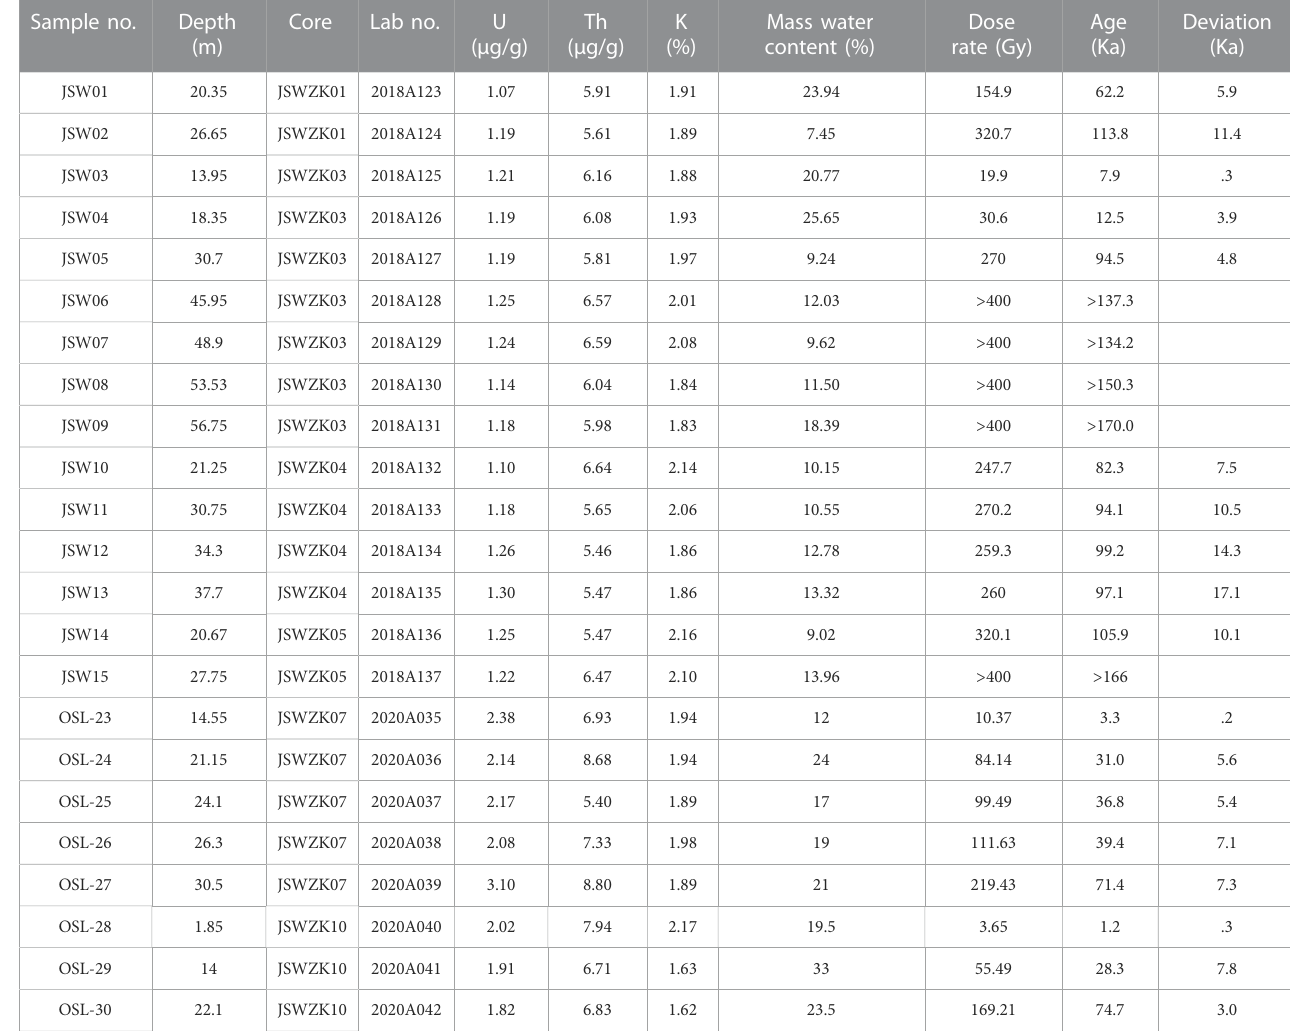
TABLE 3 OSL dates of 23 samples from the investigated boreholes. Sample